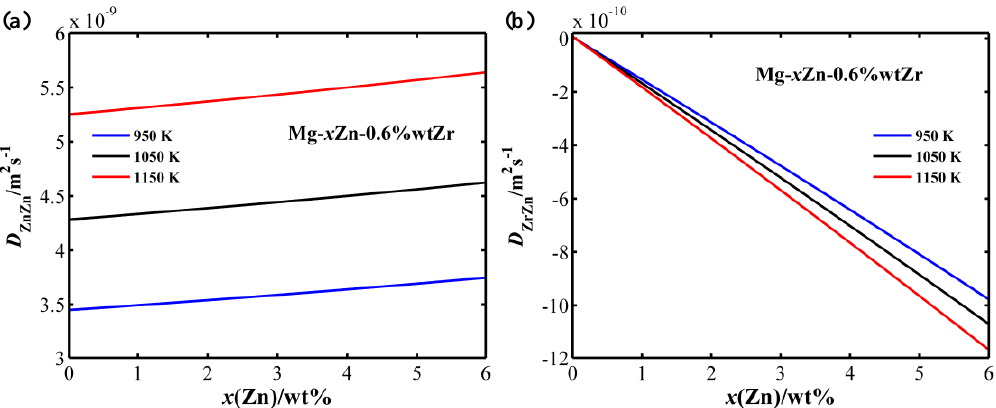
D ( a ) of Zr atoms and the cross Figure 8. Dependence of the main interdiffusion coefficient Figure 8. Dependence of the main interdi ff usion coe ffi cient D ZrZr ( a ) of Zr atoms and the cross Z r Z r interdi ff usion coe ffi cient D ZnZr ( b ) of Zn atoms on the composition of Zr in the liquid Mg-6 wt% Zn- x Zr D ( b ) of Zn atoms on the composition of Zr in the liquid Mg-6 wt% Zn- interdiffusion coefficient Z n Z r alloys at 950 K, 1050 K, and 1150 x Zr alloys at 950 K, 1050 K, and 1150 K.